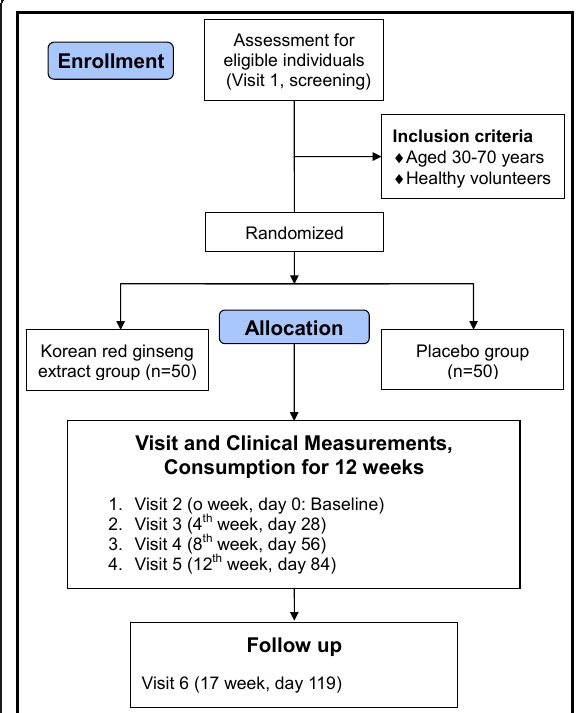
Figure 1 Flow diagram for study . Summary of the study